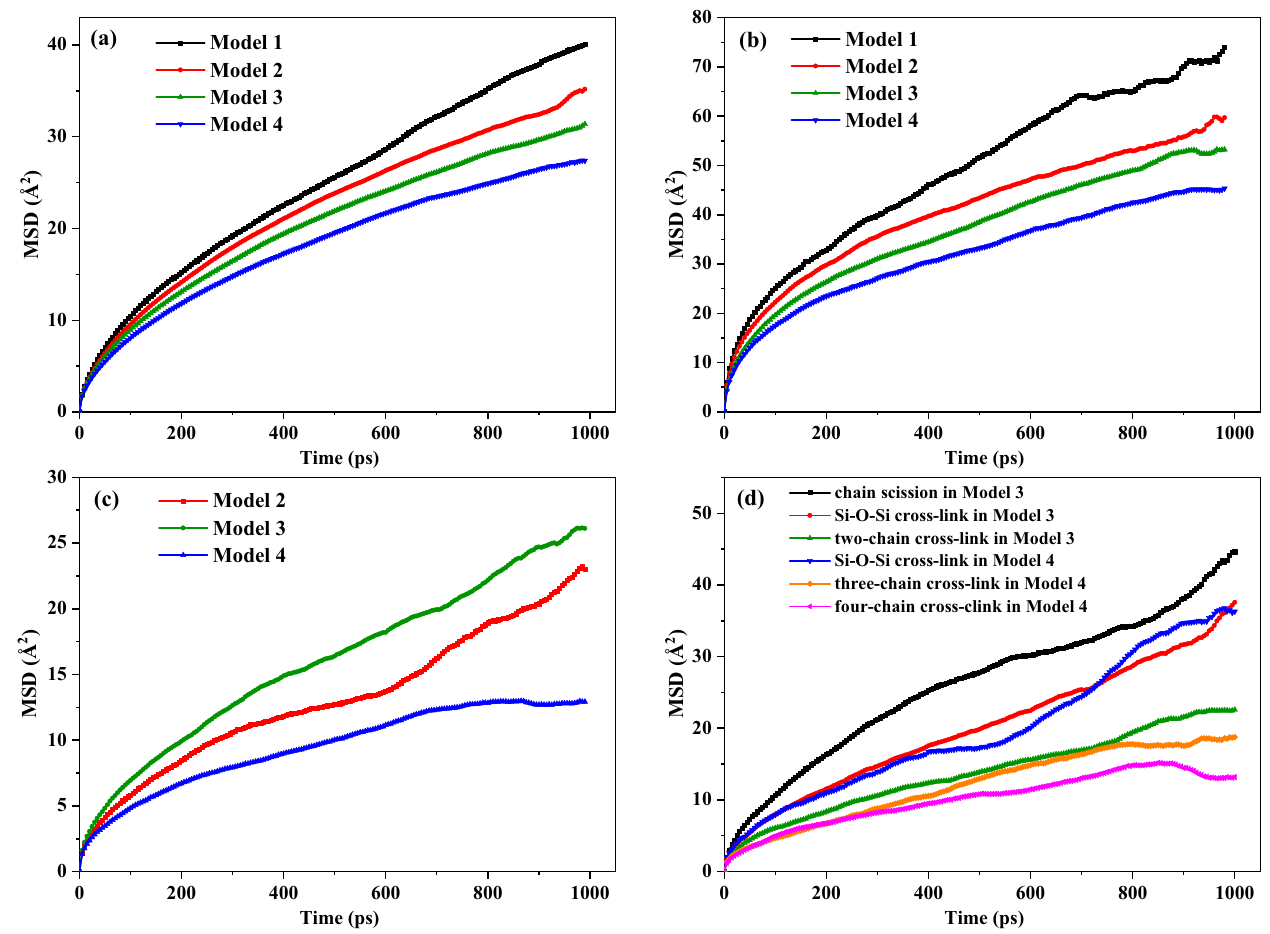
Fig. 1 MSDs of the unaged and aged nano-silica/PDMS models as a function of simulation time. a Main chain of PDMS, b oxygen of hydroxyl group of PDMS chain, c cross-link point in PDMS matrix, and d typical structure in PDMS